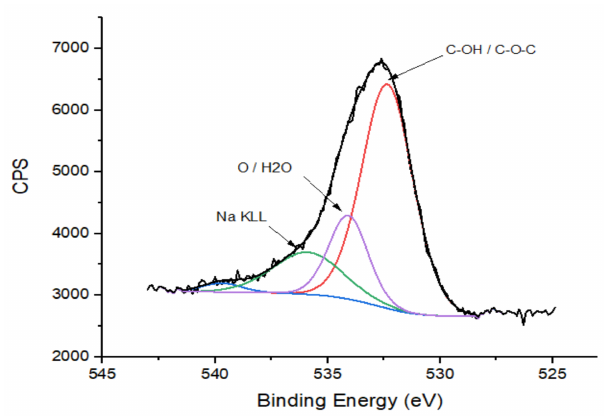
Figure 7. High-energy resolution XPS O 1s spectrum.